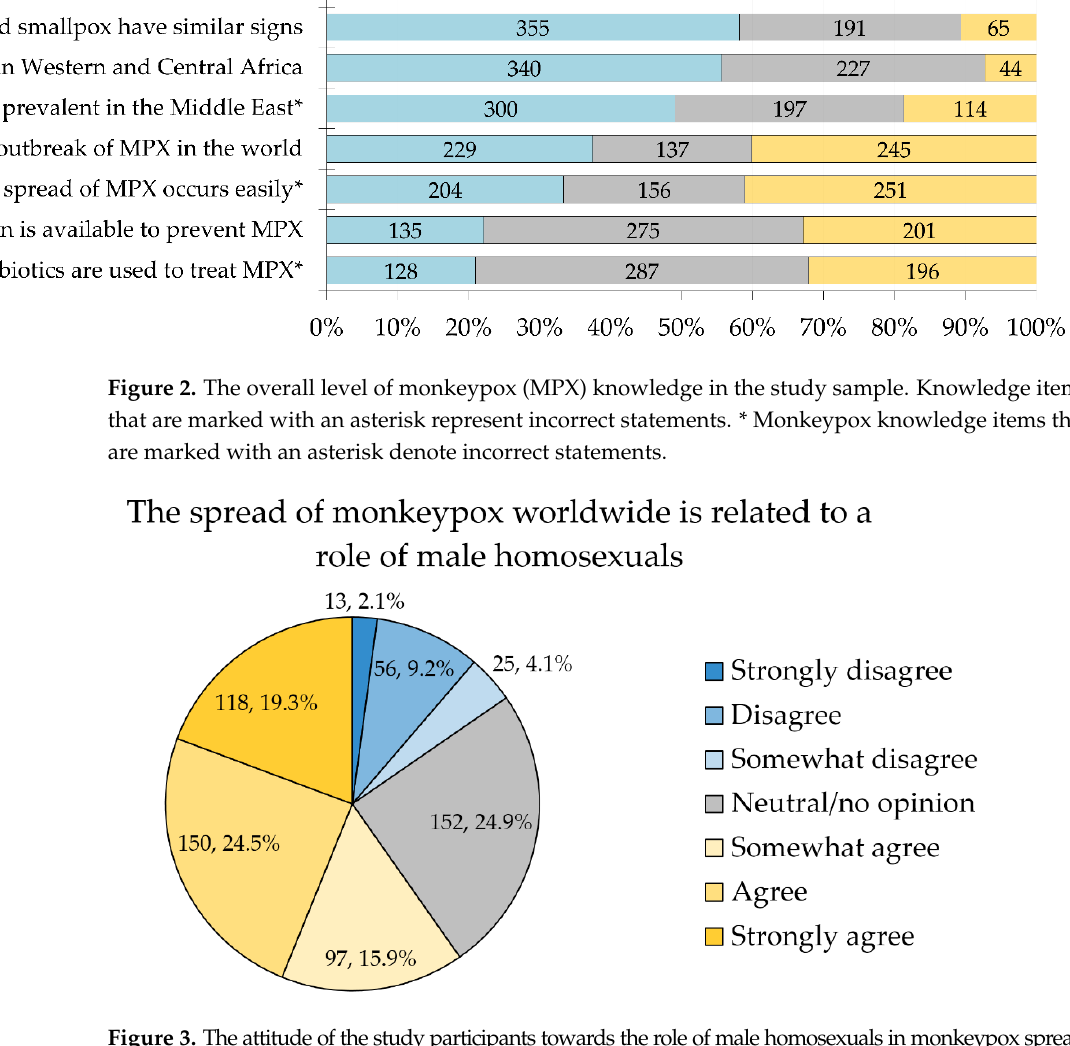
Figure 2. The overall level of monkeypox (MPX) knowledge in the study sample. Knowledge items that are marked with an asterisk represent incorrect statements. * Monkeypox knowledge items that are marked with an asterisk denote incorrect statements.